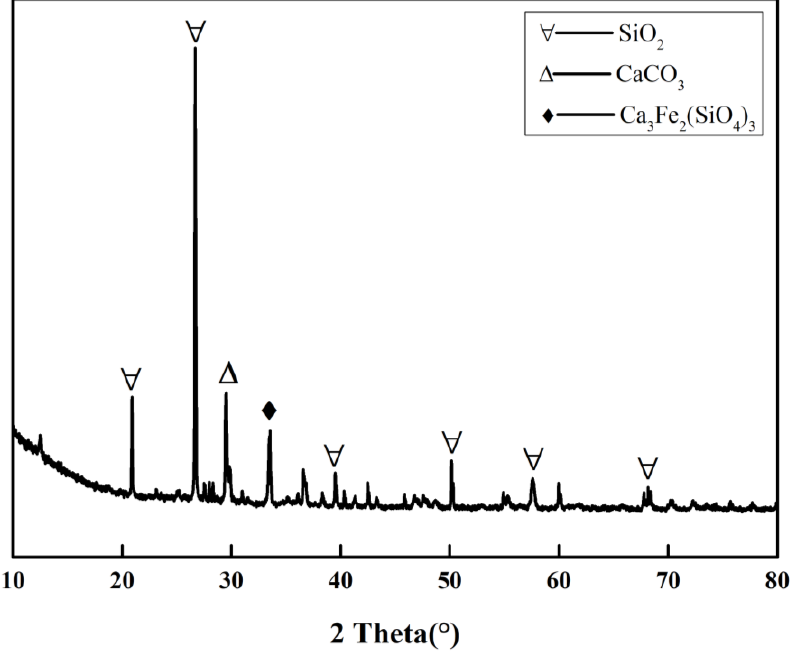
Figure 2. XRD patterns of tungsten ore tailings.